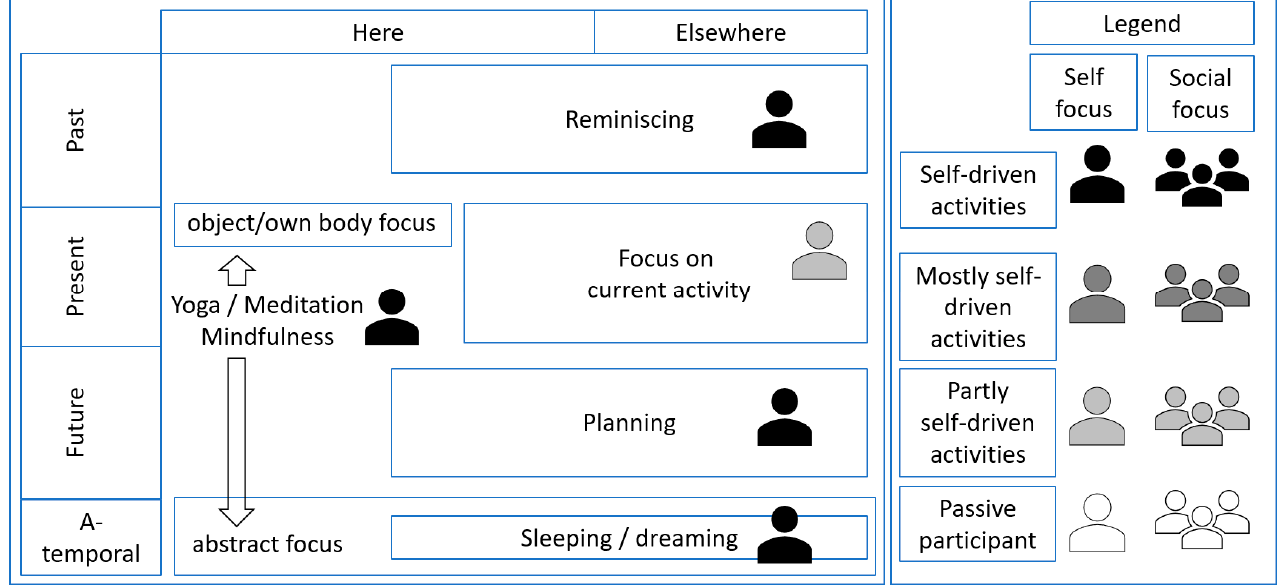
Figure 2. Schematic representation of the temporal, spatial, and social focus of attention, as illustrated in the following figures.